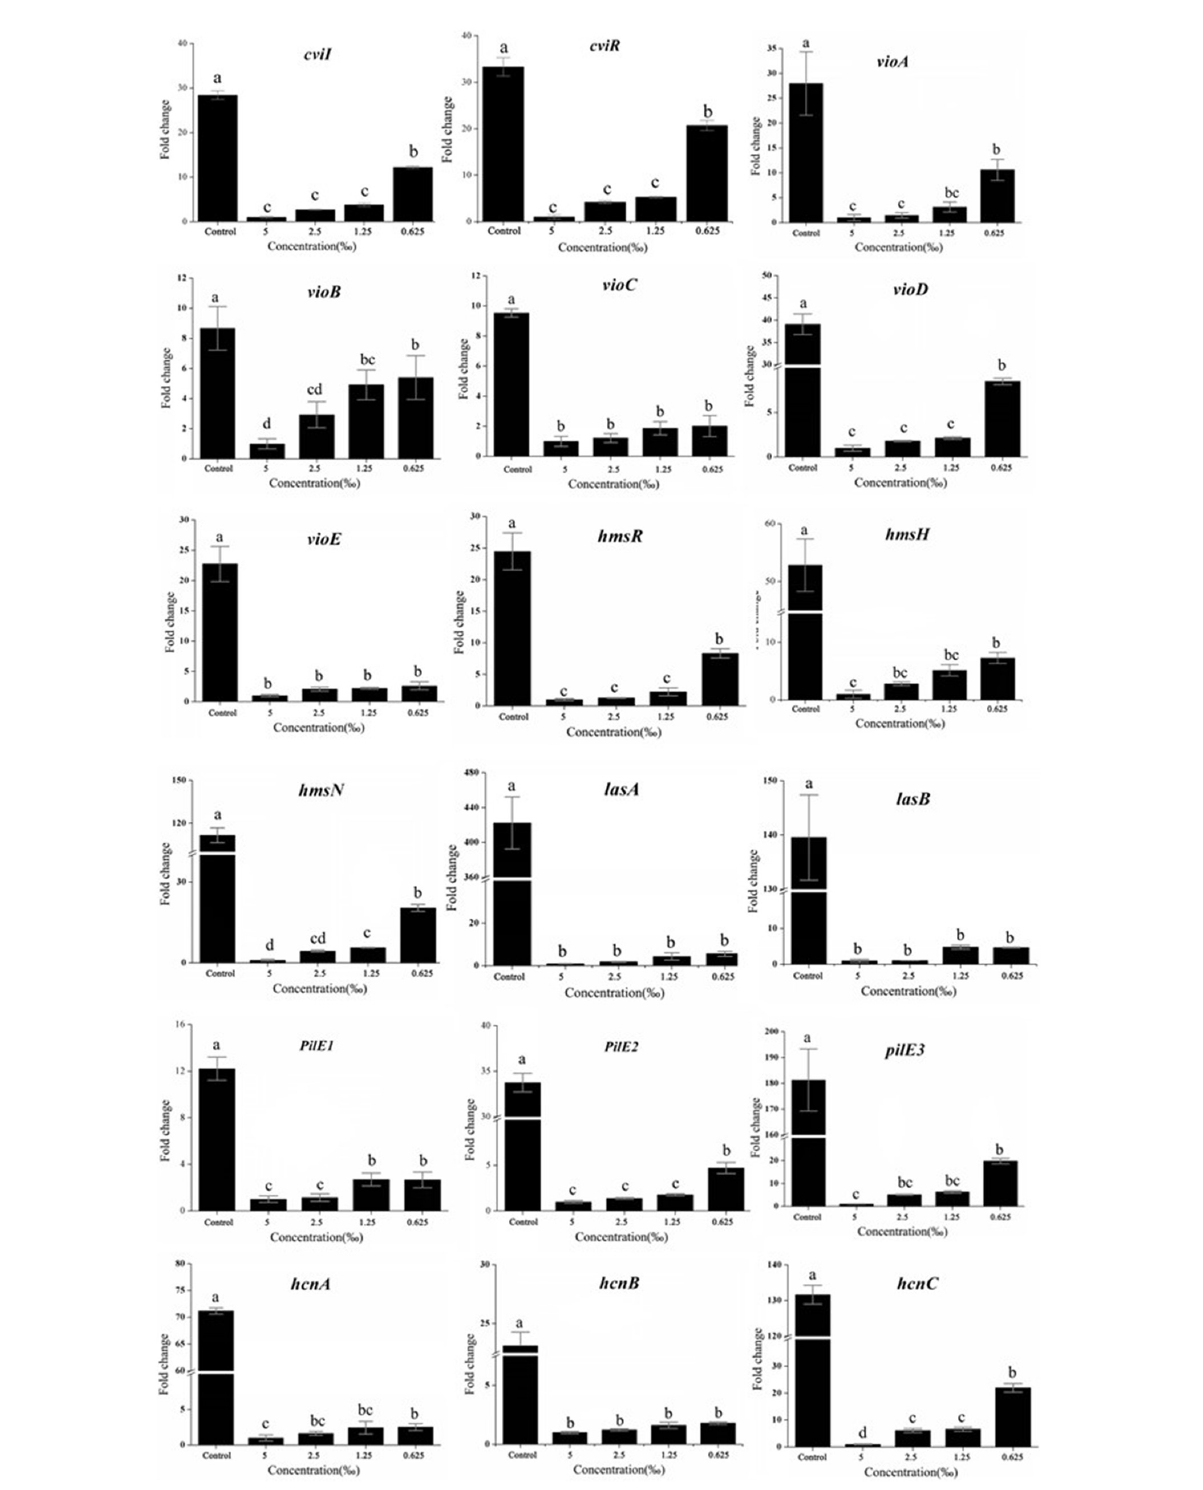
FIGURE6 Effect of methyleugenol (ME) on the expression of genes QS-regulated. The cviI , cviR , vi-oABCDE , hmsHRN , lasAB , pilE1-3 , and hcnABC were detected in response to ME treatment. Expression of the house-keeping gene, rpoD , was used as the internal control for each sample. The ME concentration of treatment was as follows: 5, 2.5, 1.25, and 0.625